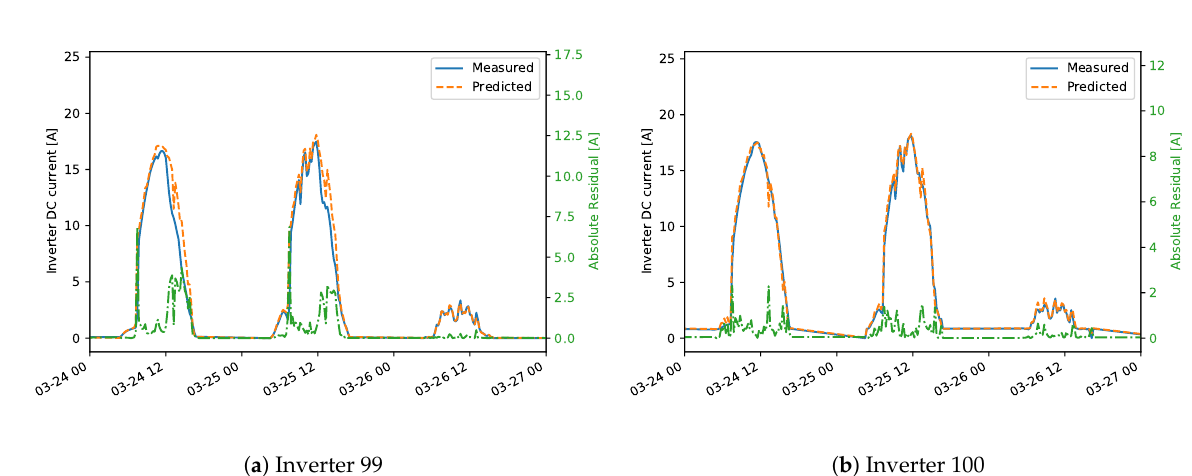
Figure 10. Detail for four inverters from plant B showing both the measured and predicted DC currents. The residuals are also shown (green dash-dotted line, right axis). The residuals are also shown (green dash-dotted line, right